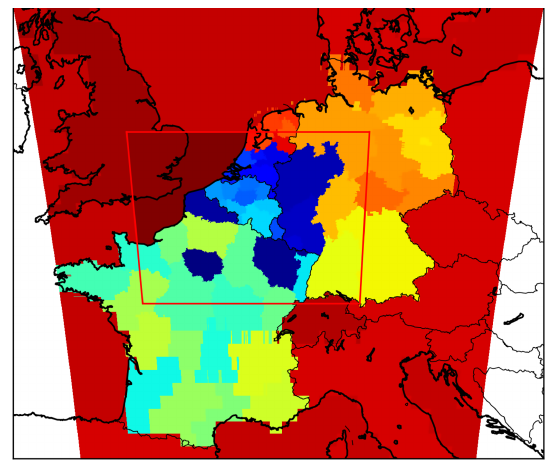
Figure 5. Administrative regions and coarser areas for which the biogenic flux budgets and the anthropogenic emission budgets (with more details for regions highlighted in Fig. 4) are controlled. The red line delimits the 2km × 2km resolution zoom of the CHIMERE transport model.